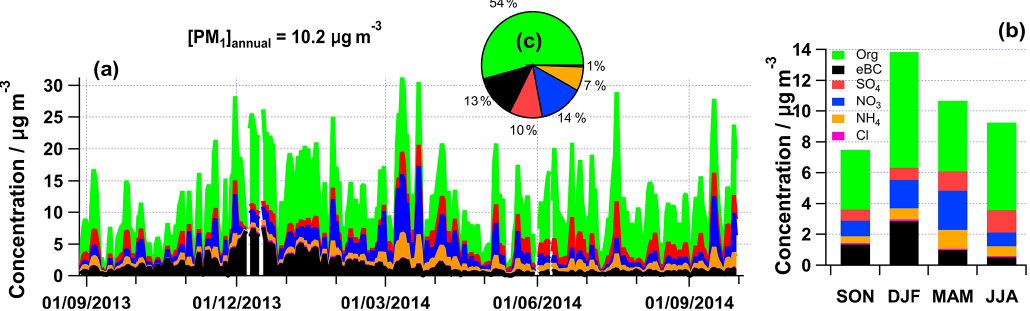
Figure 1. Chemical composition of PM 1 in Magadino 2013–2014 – daily (a) , seasonal (b) , and annual (c) averages. The labels indicate non-refractory organics (Org), sulfate (SO 4 ), nitrate (NO 3 ), ammonium (NH 4 ), and chloride (Cl) measured by the ACSM and equivalent black carbon (eBC) measured by light absorption.